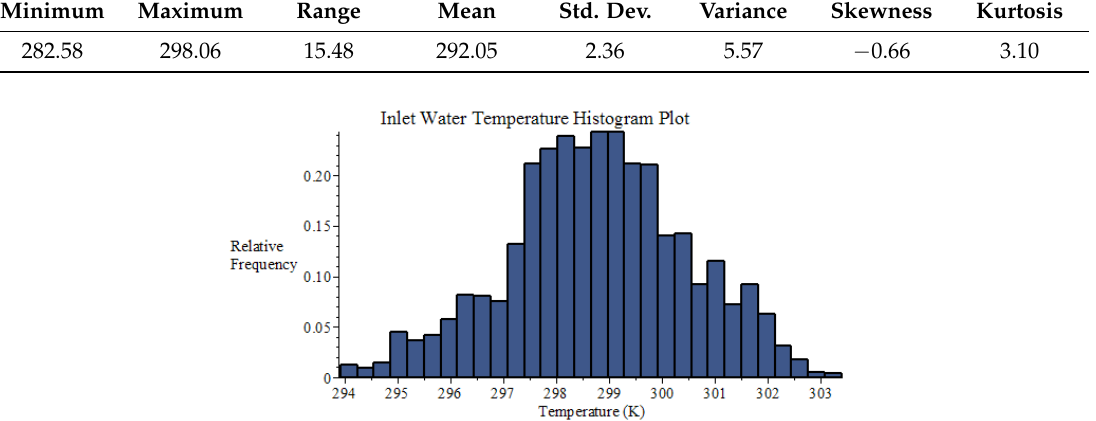
Figure B2. Histogram plot of dew-point air temperature data collected by SRNL from F-Area cooling towers (unsaturated conditions). Table B5. Statistics of the dew-point temperature distribution [K].